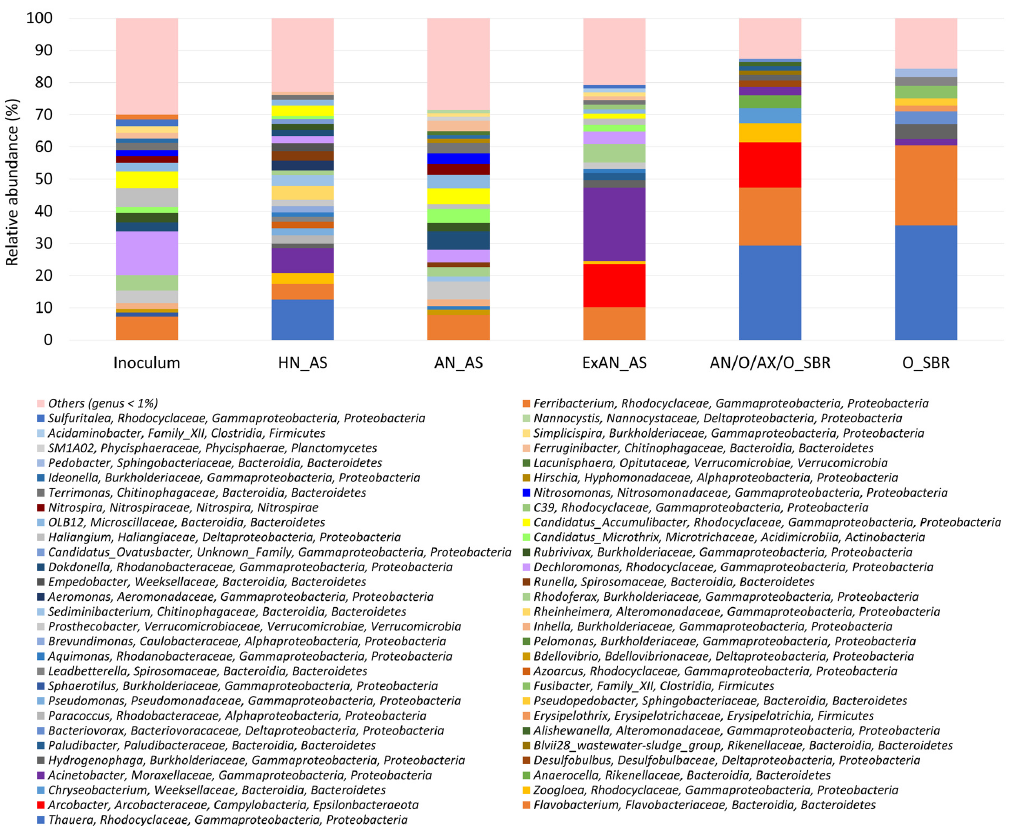
Figure 3. Microbial selection and population dynamics at genus-level inoculum, heterotrophic nitrification (HN_AS), autotrophic nitrification (AN_AS), extended anaerobic activated sludge (ExAN_AS) bioreactors, as well as granular biomass bioreactors (i.e., AN/O/AX/O_SBR and O_SBR). The legend shows genus, family, and phylum. Table 3. Dominant bacterial species under different selection pressures.